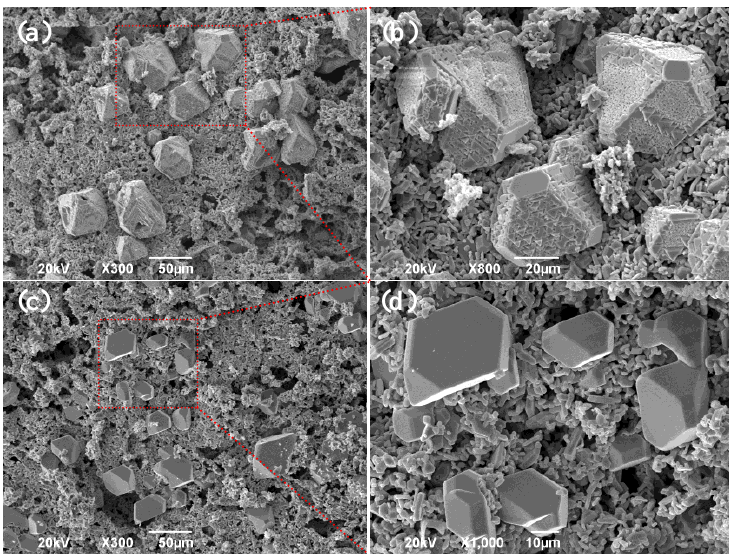
Figure 10. SEM images of the roasted products: ( a ) and ( b ) programmed cooling; and ( c ) and ( d ) natural cooling.